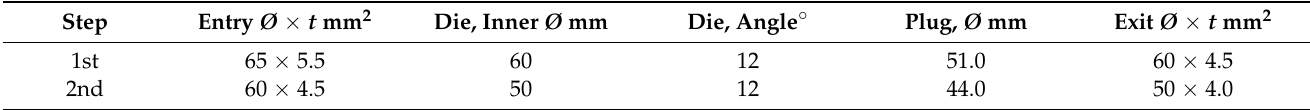
Table 2. Drawing steps. Ø : diameter, t : wall thickness.